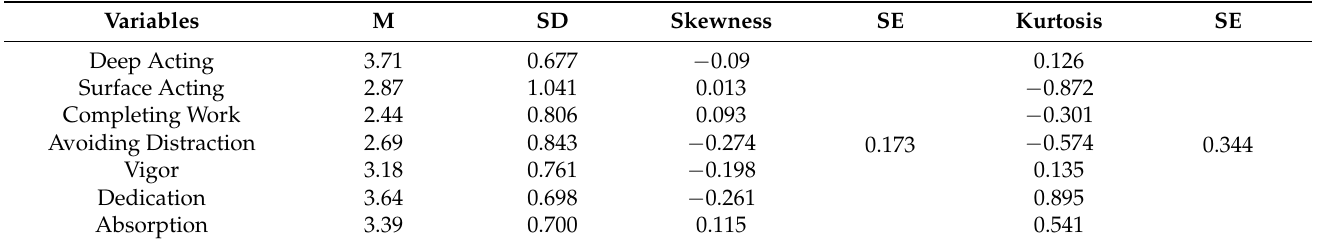
Table 3. Test of normality.